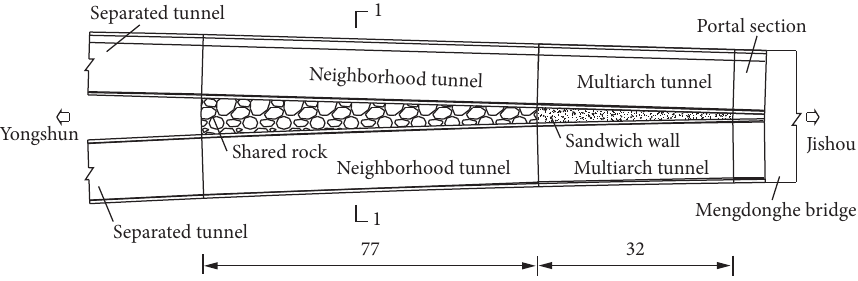
Figure 1: Plan view of the neighborhood tunnel (unit: m).